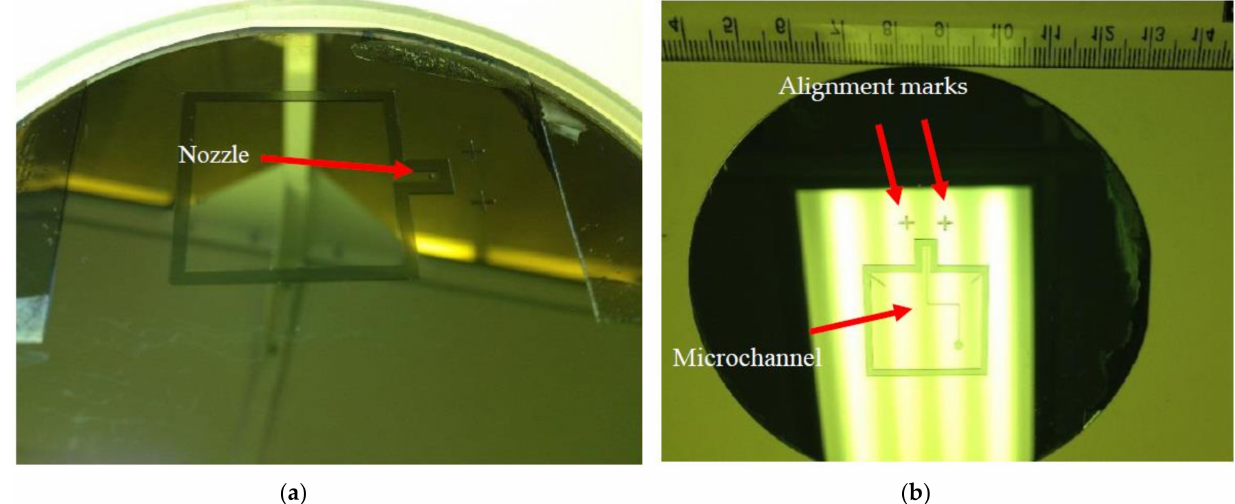
Figure 4. The final fabricated molds: ( a ) nozzle mold and ( b ) microchannel